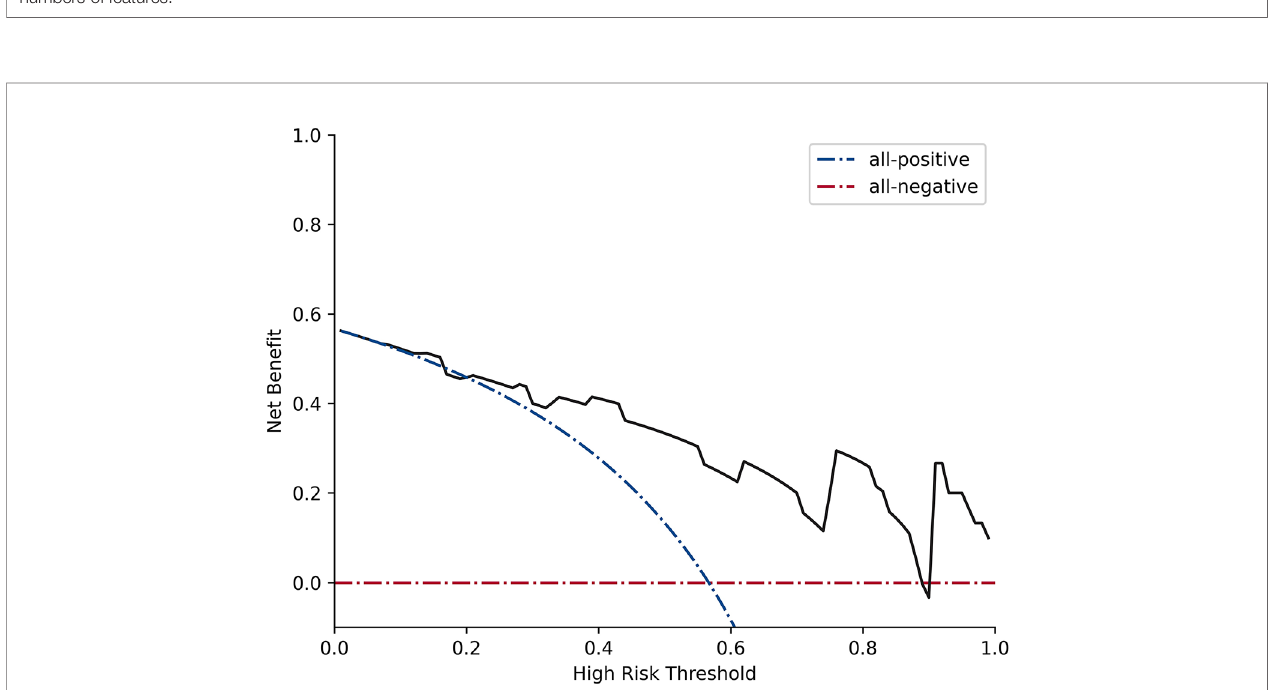
FIGURE 4 | Decision curve analysis for RFE_LinearSVC. The black line represents the true divisional capacity in distinguishing SCNs from